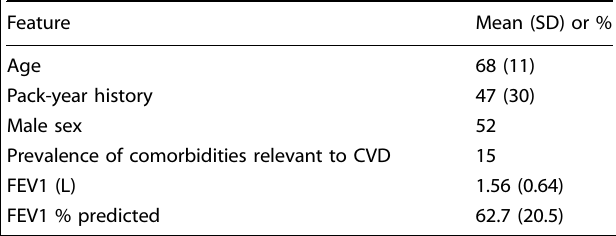
Table 2. Characteristics of the INTEGR COPD study